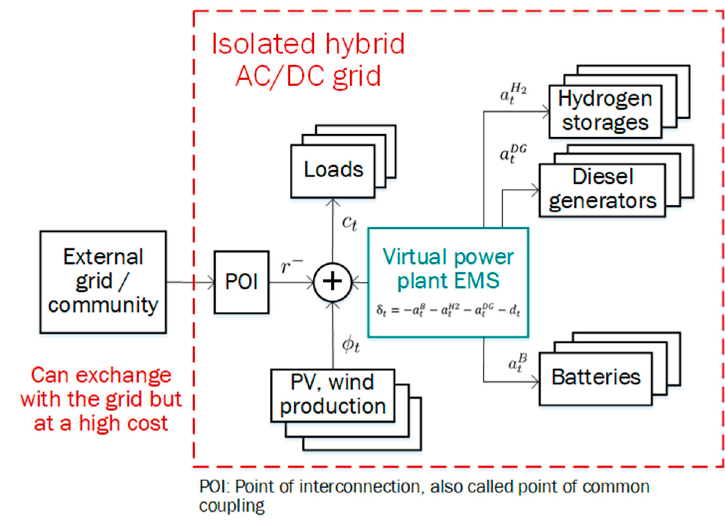
Figure 3. A general scheme of the hybrid AC / DC power grid featuring distributed energy resources (DERs) associated with possible inclusions options batteries, hydrogen storages and diesel unit devices.